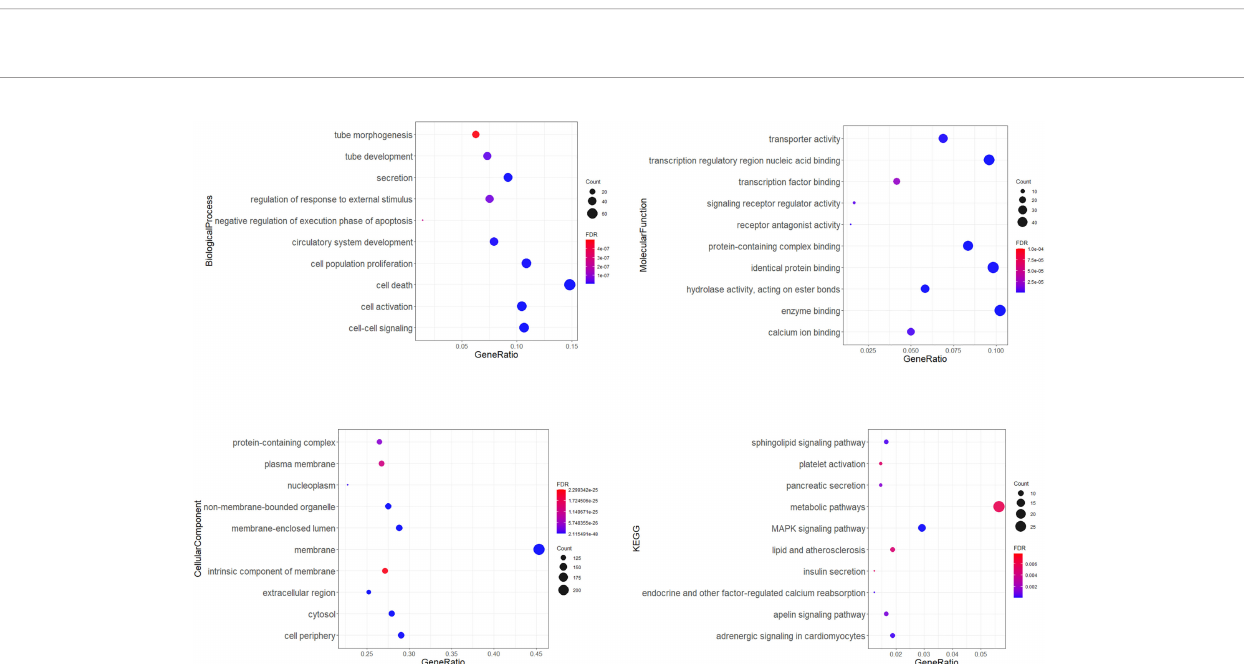
FIGURE 5 | Gene ontology (GO) enrichment analysis. Dot plots showing top 10 signi fi cantly enriched GO terms of the target genes in the biological process, molecular function, cellular components, and top 10 KEGG (Kyoto Encyclopedia of Genes and Genomes) connected with cardiovascular diseases and diabetes. The colors of the nodes are illustrated from red to blue in descending order of the FDR adjusted p -value. The sizes of the nodes are shown from small to large in ascending order of gene counts. The x-axis represents the gene ratio, and the y axis represents the GO or KEGG terms. GO: Gene Ontology; KEGG: Kyoto Encyclopedia of Genes and Genomes.